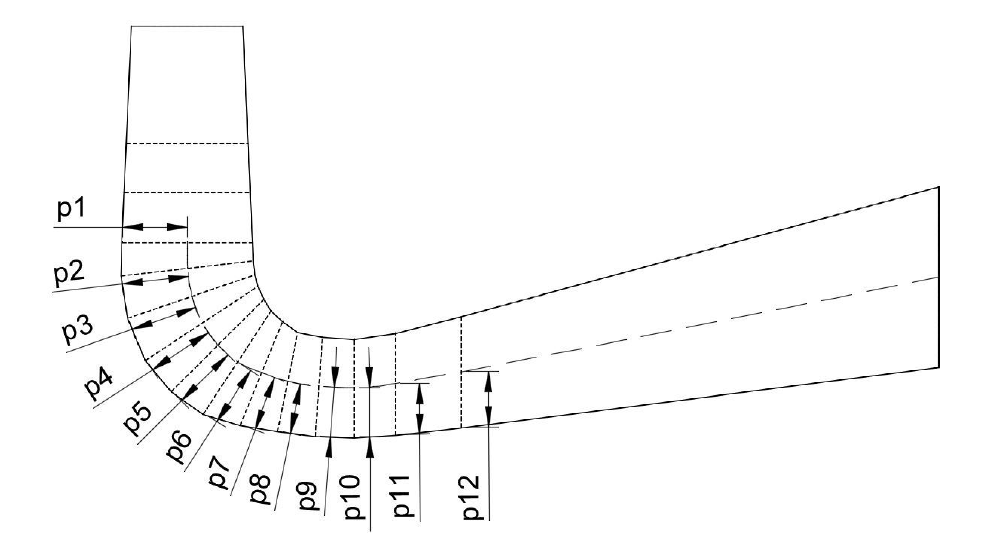
Figure 2. Draft tube with indicated geometry parameters.